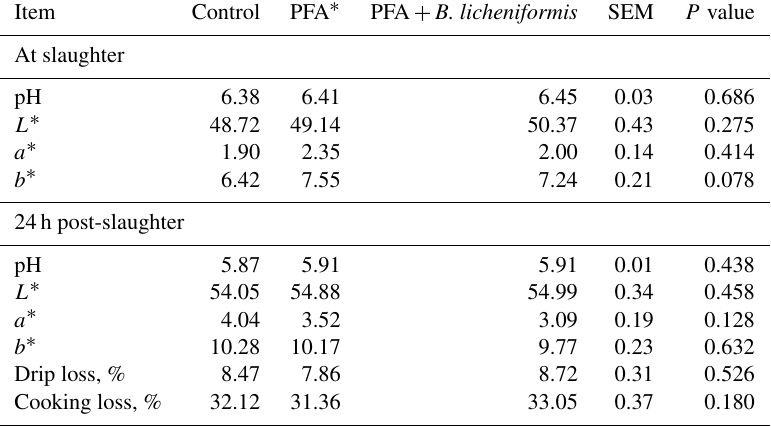
Table 4. Meat quality of broiler chickens fed supplemental phytogenic feed additive alone or in combination with Bacillus licheniformis . Item